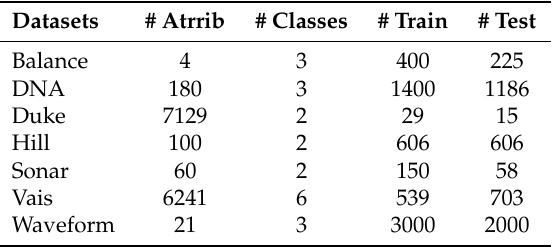
Table 6. Specifications of classification benchmark datasets.